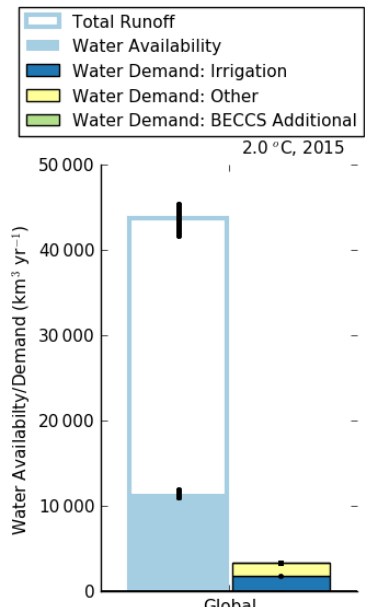
Figure 13. Global water availability (filled light blue bar) as a re- gionally dependent fraction of runoff (hollow light blue bar) for the year 2015. The water demand for irrigation (dark blue) and for other uses (i.e. energy generation, industry, and domestic; yellow) are taken from the SSP2-RCP2.6-IMAGE database. Note that there is very little BECCS additional water demand (green) in